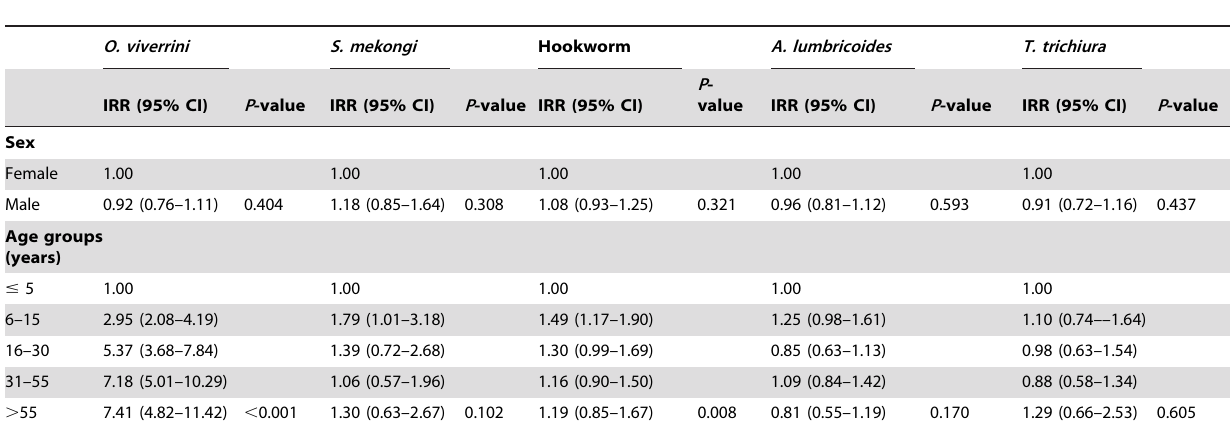
Table 2. Negative binomial regression analyses for parasite eggs count in Champasack province (n =669).